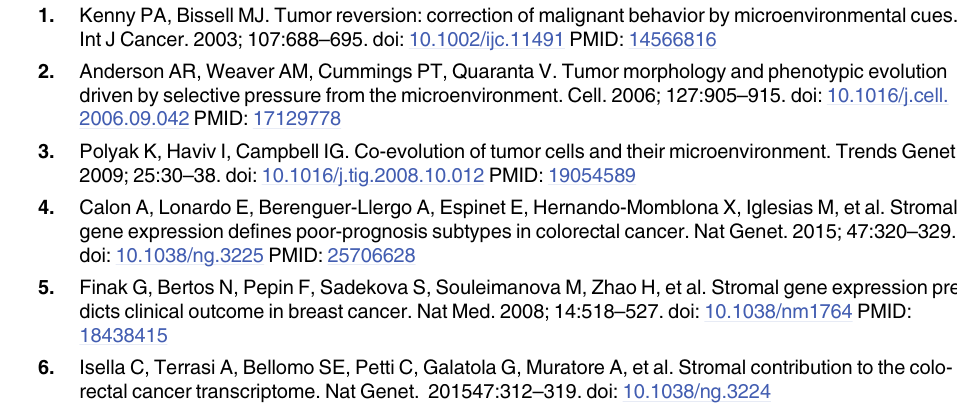
S2 Table. Copy number alterations significantly enriched in EDI-high, grade 3 breast tumors. S3 Table. Prognostic significance of 4p14 and 5q13 loss and EDI groups in independent subsets of grade 3 breast tumors in univariate and multivariate Cox regression with node status and tumor